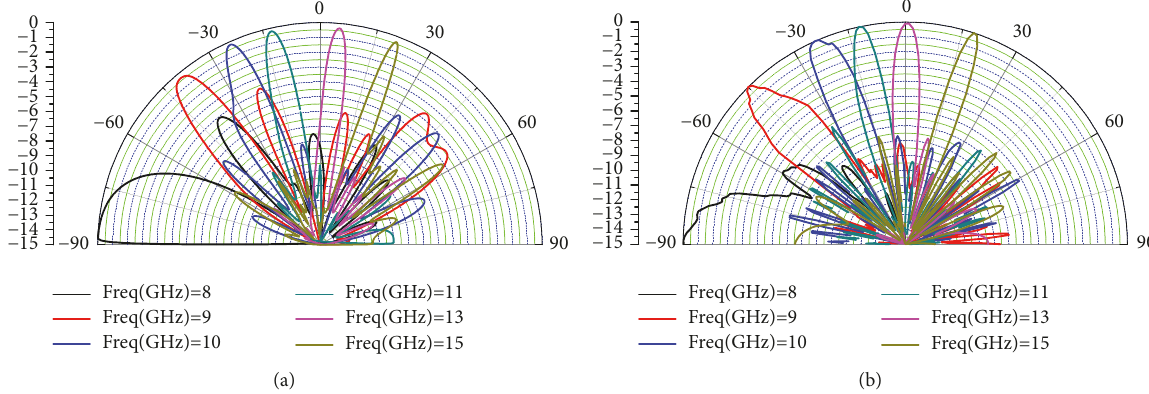
Figure 17: 𝜑 =0 ∘ plane simulated and measured results of antenna. (a) Simulated result. (b) Measured result.